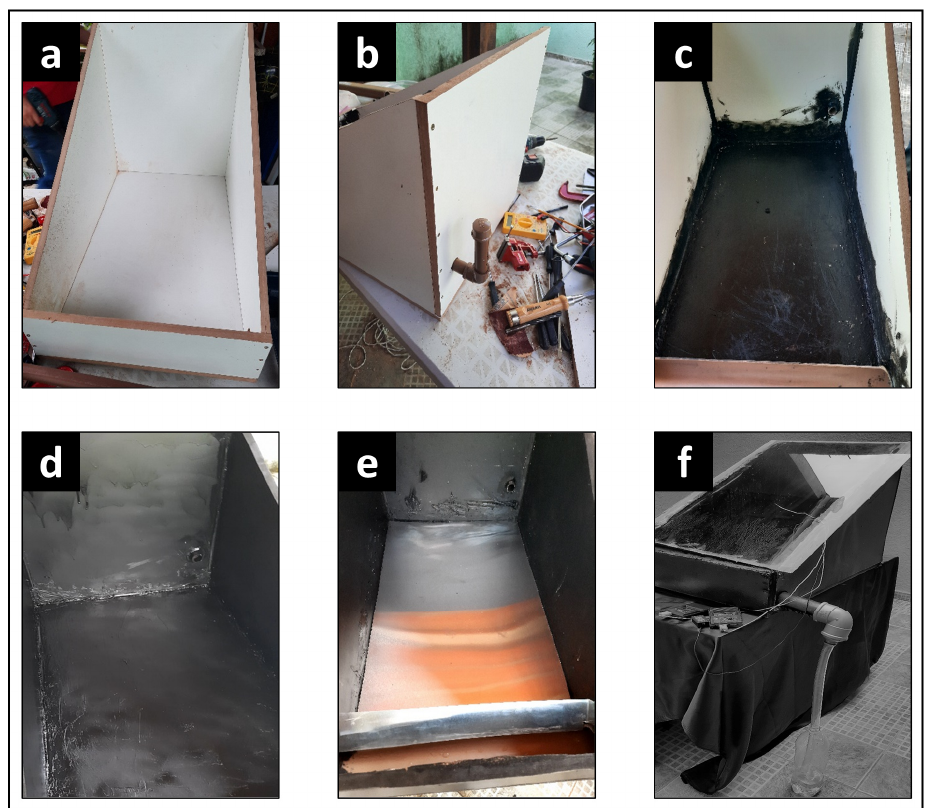
Figure 2. Process of building the solar still. The sequence is described in the text. Table 1. Physical-chemical characteristics of used mineral water.